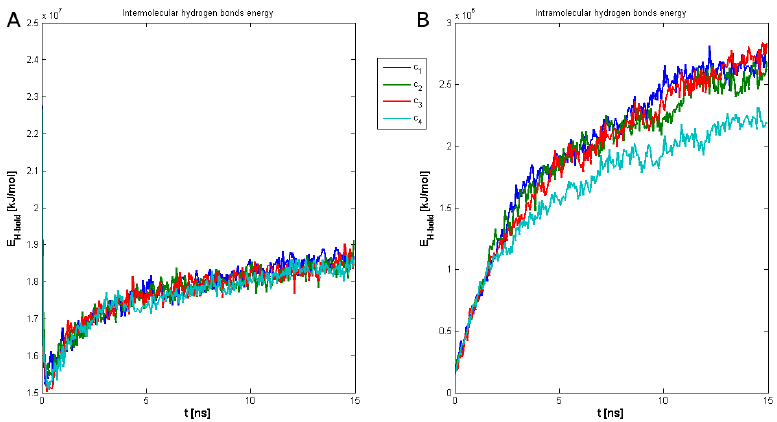
Figure 4. Total hydrogen bond energy in pathologic HA networks with increasing concentration of phospholipids: ( A ) intra-molecular H-bond energy is depicted; and ( B ) inter-molecular bond energy.